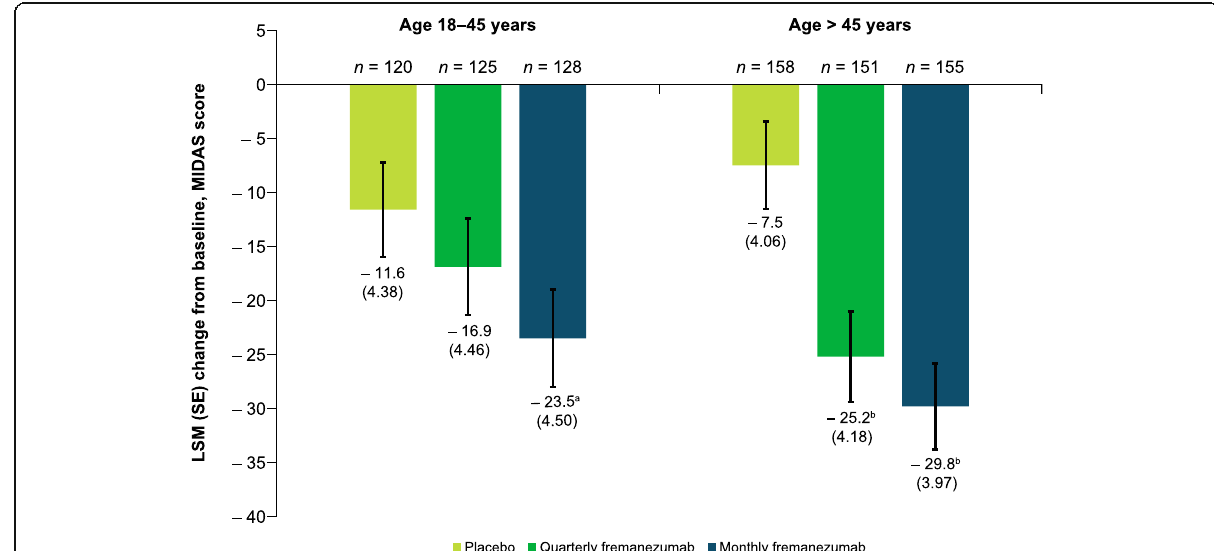
Fig. 3 Change in MIDAS scores at 12 weeks by age. MIDAS, Migraine Disability Assessment; LSM, least-squares mean; SE, standard error. a P = 0.021 vs placebo. b P < 0.001 vs